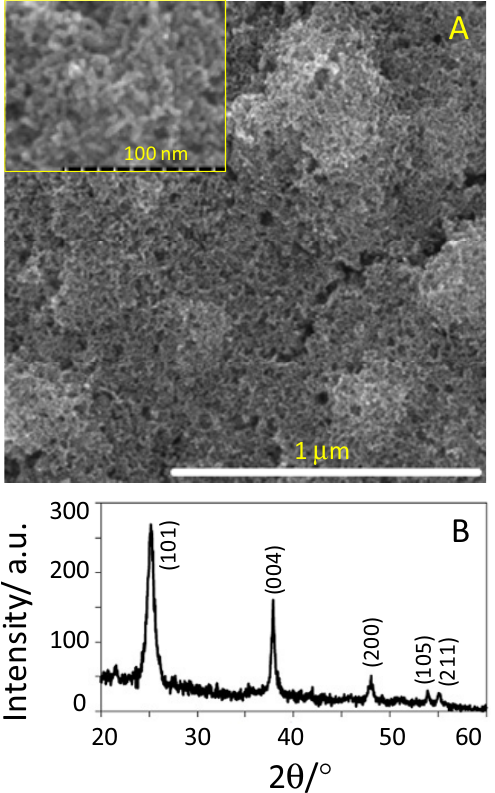
Fig. 1. (A) Typical FESEM image of TiO 2 nanorice grown on an ITO substrate prepared using a growth solution containing 0.05 M of ammonium hexafluoro titanate (AHT), and 0.08 M HMT. Inset shows detailed structure of nanorice. (B) XRD pattern of the TiO 2 nanorice on ITO